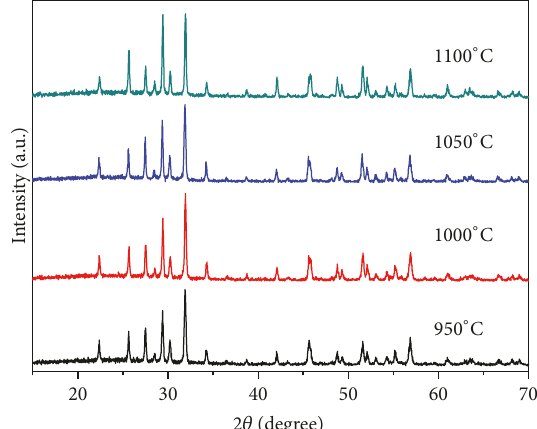
Figure 3: XRD patterns of the flux-synthesized SBN nanocrystals with flux-to-reactant weight ratio of 2 :1 at a reaction temperature of 1100 ∘ C for 3h.